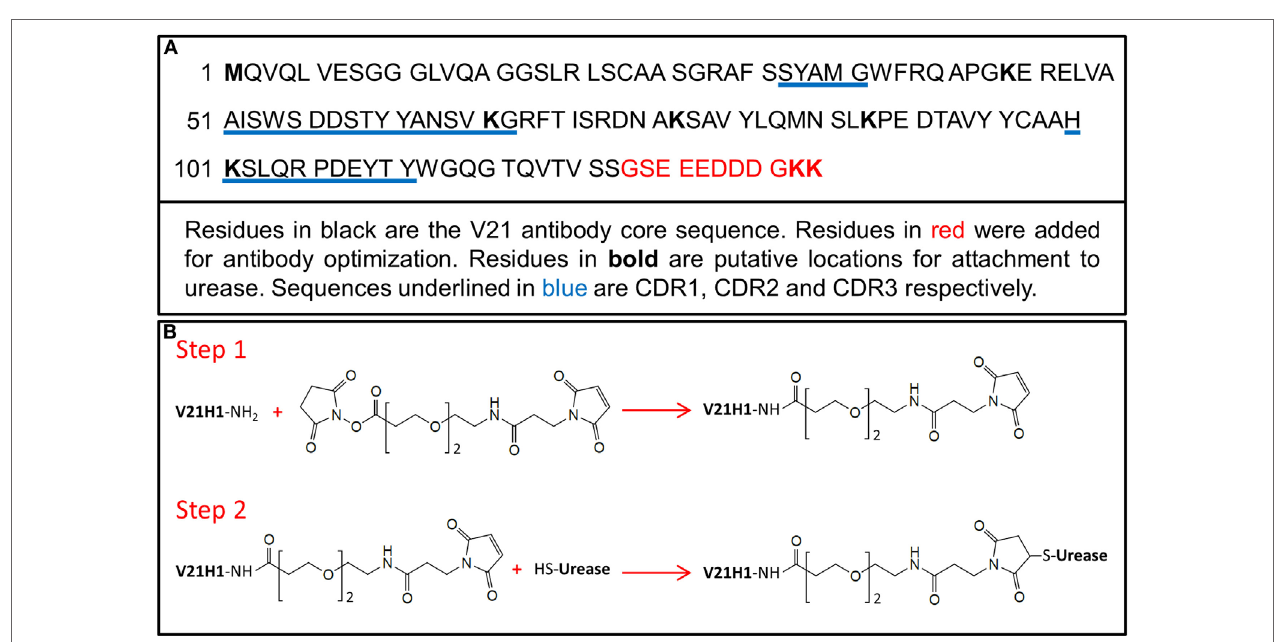
FigUre 1 | (a) Amino acid sequence of the V21H1 antibody. (B) Description of conjugation strategy used to conjugate V21H1 to urease to generate V21H1- DOS47. Step 1 is the activation of the antibody using SM(PEG) 2 . Step 2 conjugates the activated antibody to